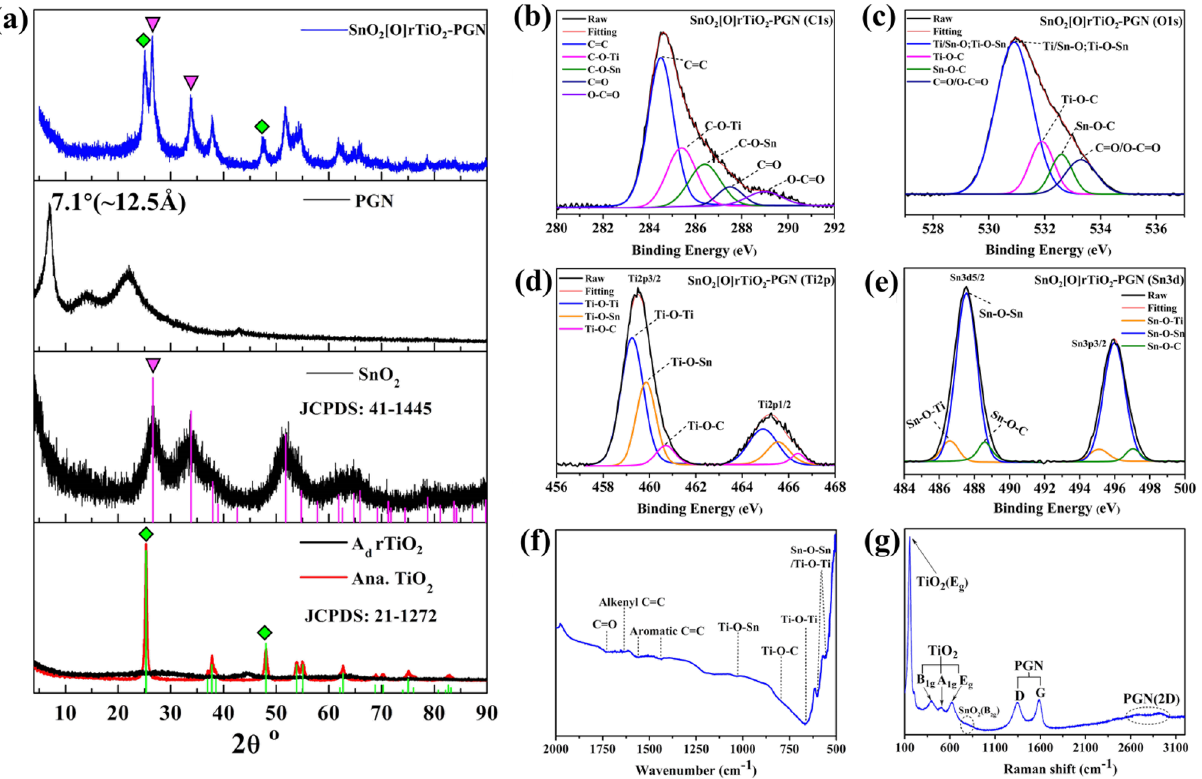
Figure 2. Structure and bonding state characterization of SnO 2 [O]rTiO 2 -PGN: ( a ) XRD patterns of SnO 2 [O] rTiO 2 -PGN, PGN, SnO 2, and A d , Ana. TiO 2 . ( b – e ) SnO 2 [O]rTiO 2 -PGN XPS spectra of C1s, O1s, Ti2p, and Sn3d, respectively. The deconvoluted bonding species are labeled. ( f ) FT-IR and ( g ) Raman patterns of SnO 2 [O] rTiO 2